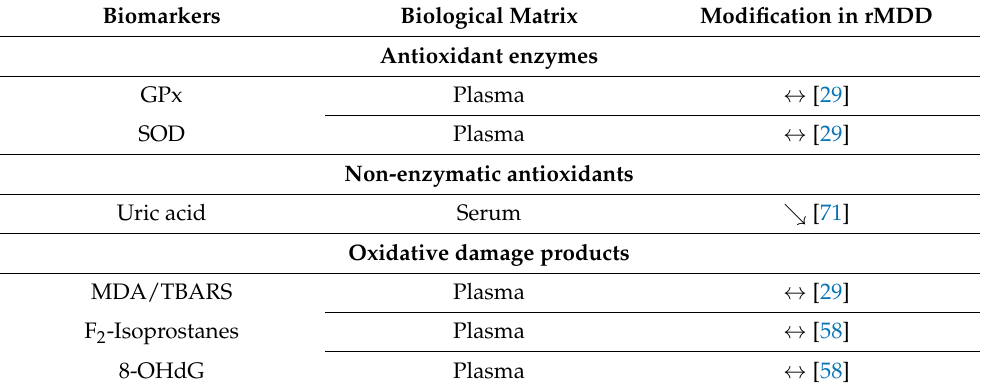
Table 5. Peripheral biomarkers of oxidative stress in MDD patients in remission compared to healthy controls . rMDD: Major depressive disorder in remission—GPx: Glutathion Peroxydase— SOD: Superoxide dismutase (information about isoform was not provided)—MDA: Malondialdehyde— TBARS—Thiobarbituric Acid-Reactive Substances—8-OHdG: 8-hydroxy-2 (cid:48) -deoxyguanosine— (cid:37) : Val- ues significantly higher in depressed patients compared to controls— (cid:38) : Values significantly lower in depressed patients compared to controls— ↔ : No significant difference between depressed patients and controls.